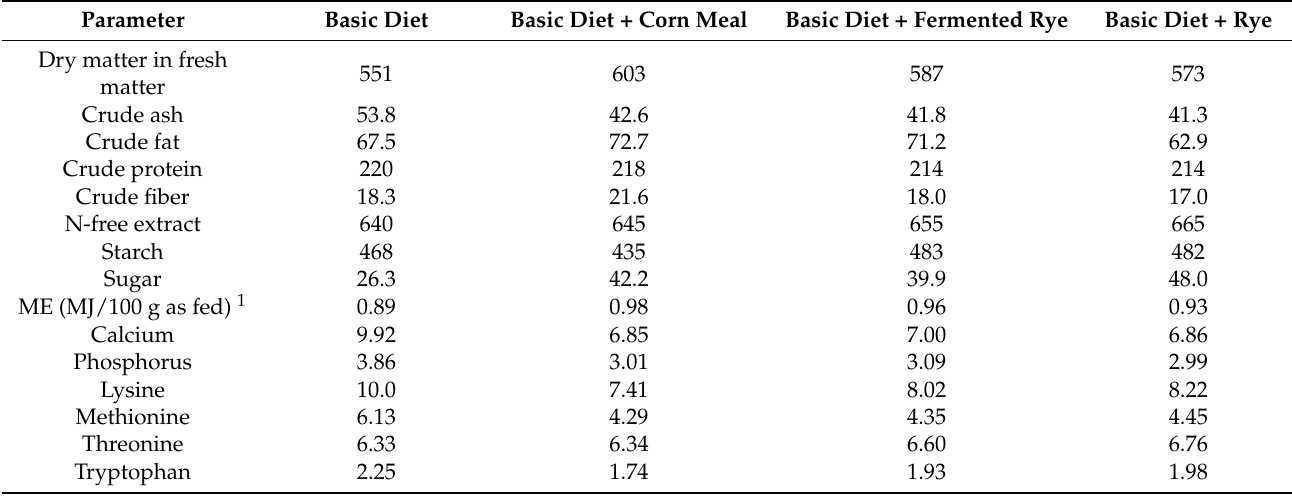
Table 3. Chemical composition (in g/kg DM) of the vegetarian diet (basic) and the experimental diets supplemented with hydrolyzed feather meal as well as either corn meal, fermented rye or rye.